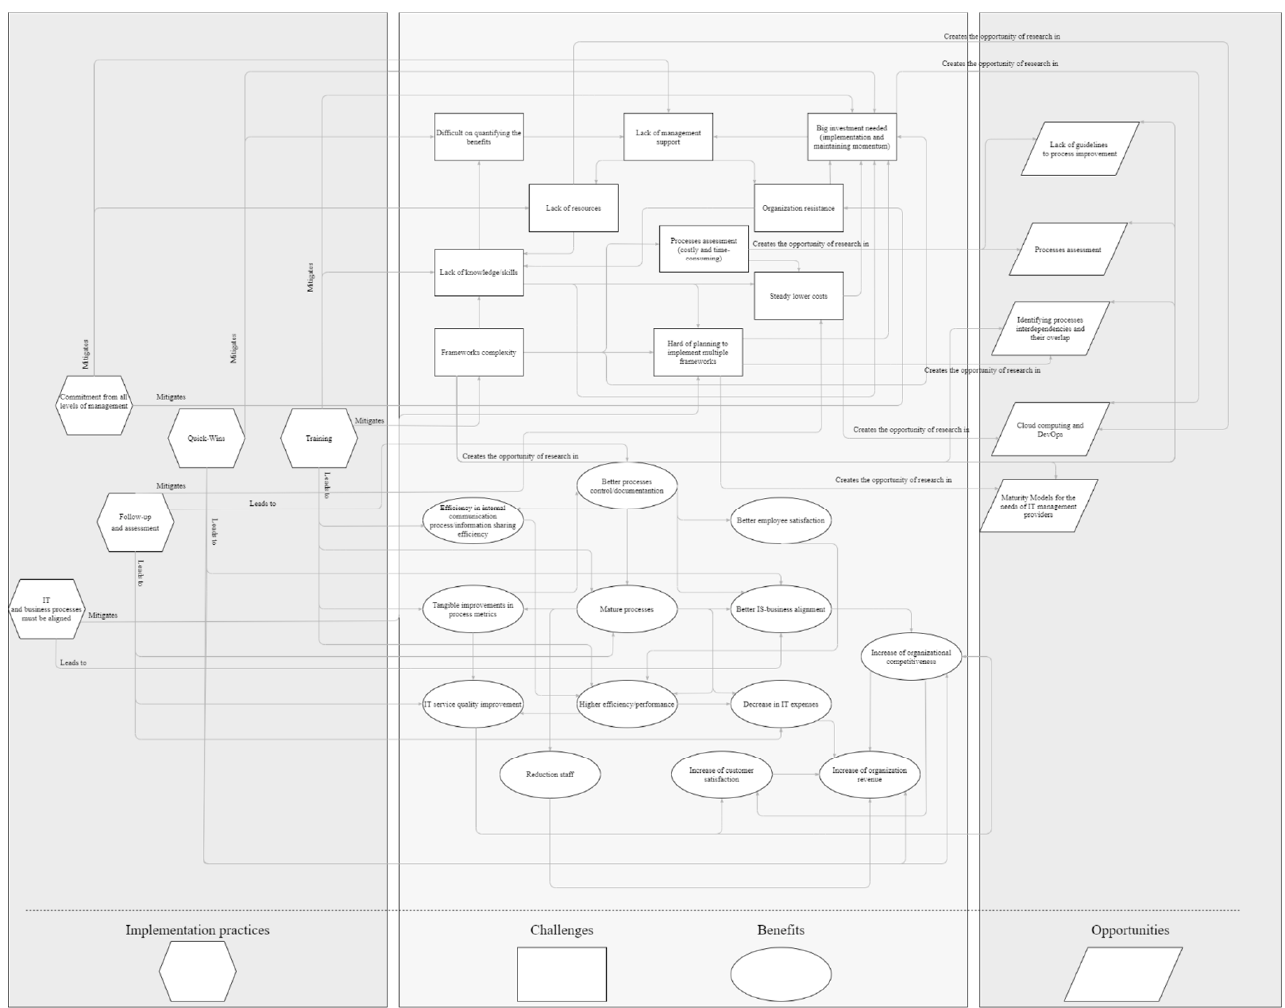
Figure 9. Conceptual Model of ITSM Main Concepts.